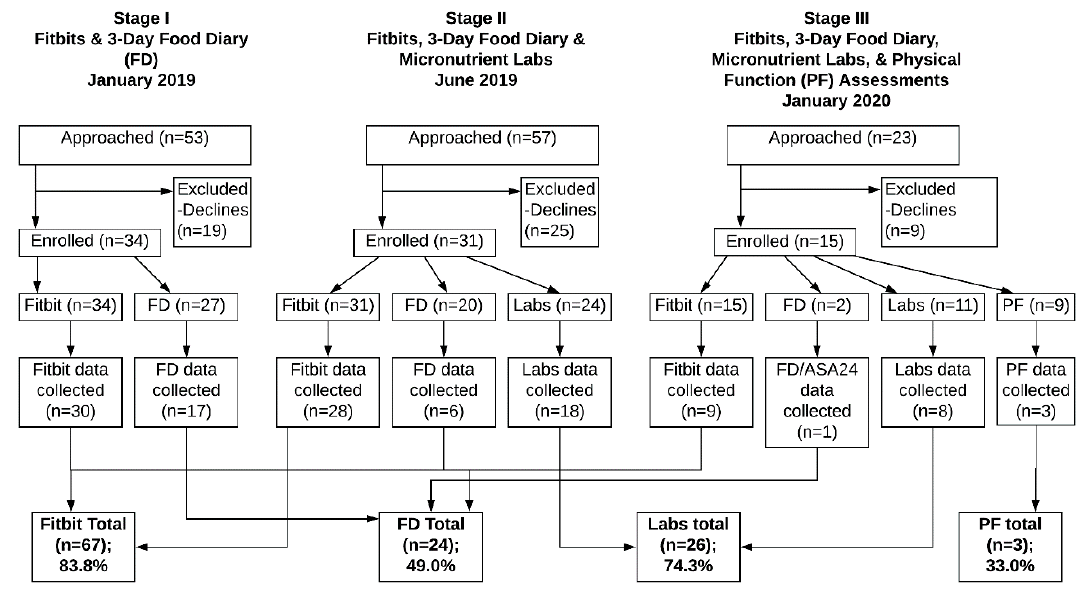
Figure 1. Flow diagram of the energy balance (EB) repository.